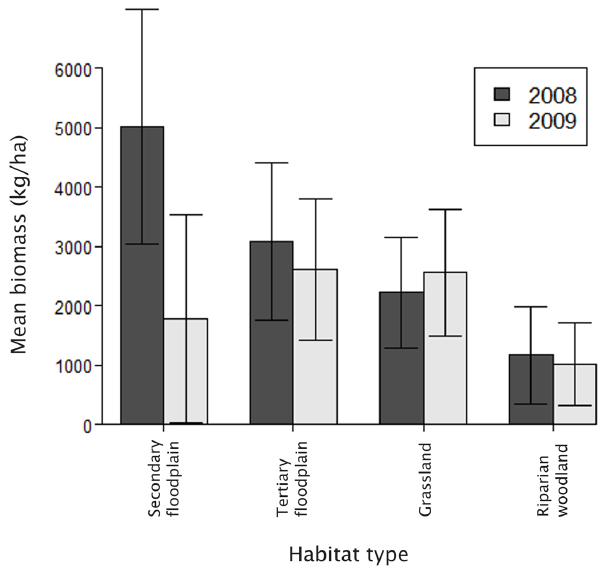
Figure 4. Mean herbaceous biomass in four habitats during the 2008 and 2009 late flood seasons. Error bars represent one standard deviation.